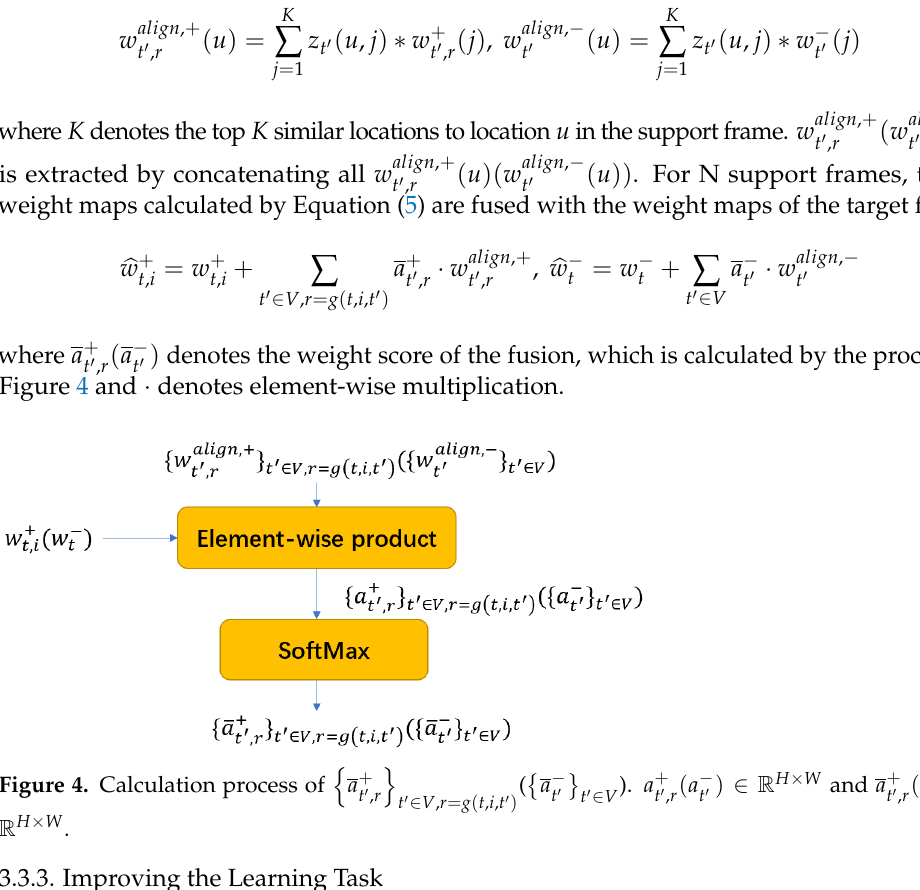
( a − ) ∈ t (cid:48) , r t (cid:48)